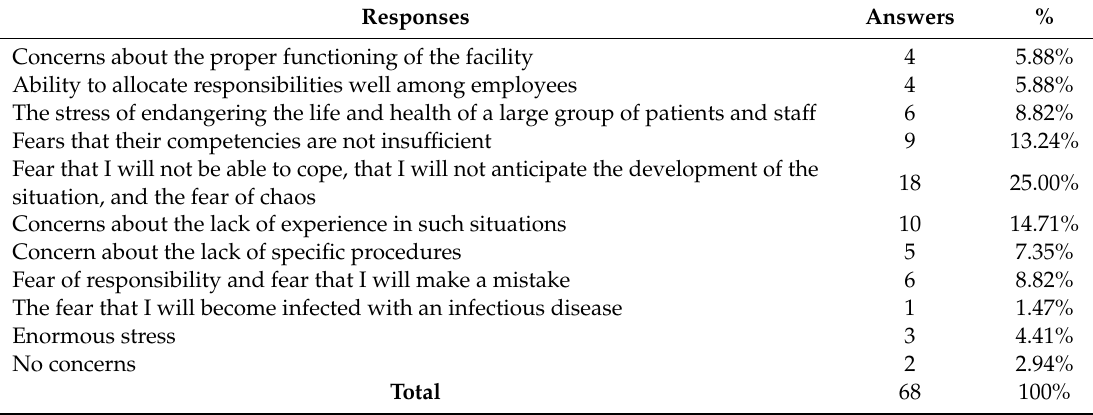
Table 4. Concerns the respondents felt about their ability to manage a crisis